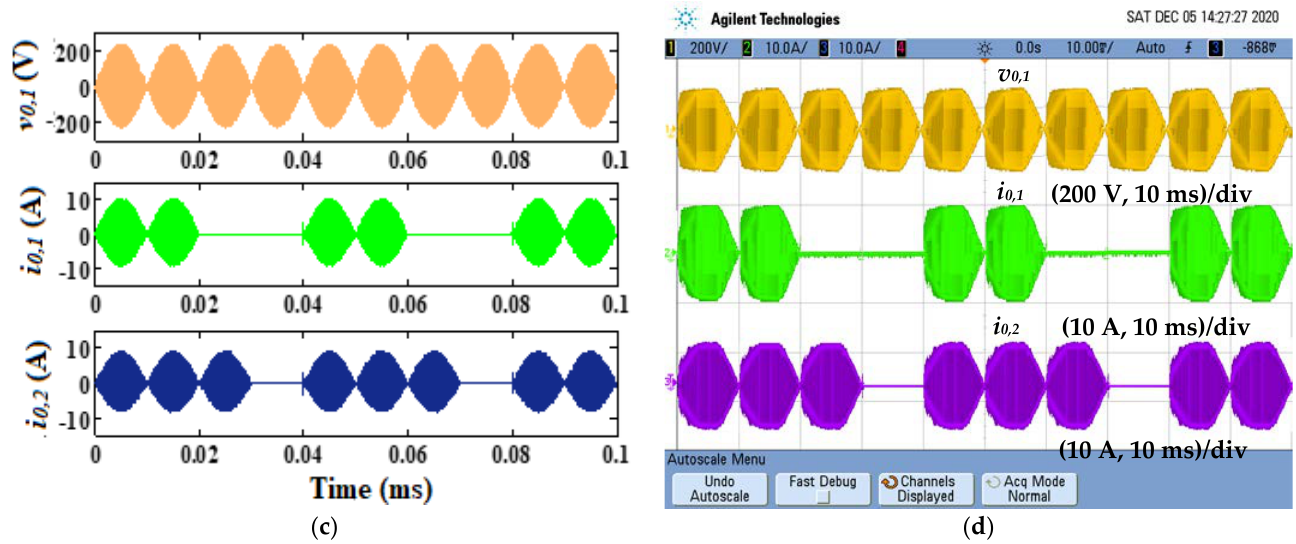
Figure 10. Voltage and currents waveform of 25% D PDM for load 1 and 100% D PDM for load 2 ( a ) simulation, ( b ) hardware, voltage and currents waveform of 50% D PDM for load 1 and 75% D PDM for load 2 ( c ) simulation, ( d ) hardware. Table 4. Efficiency of the IH system with independent control.